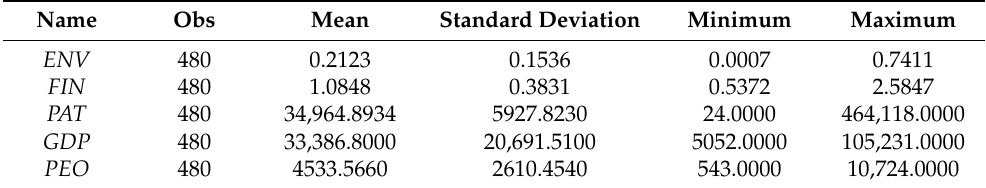
Table 1. Variable descriptive